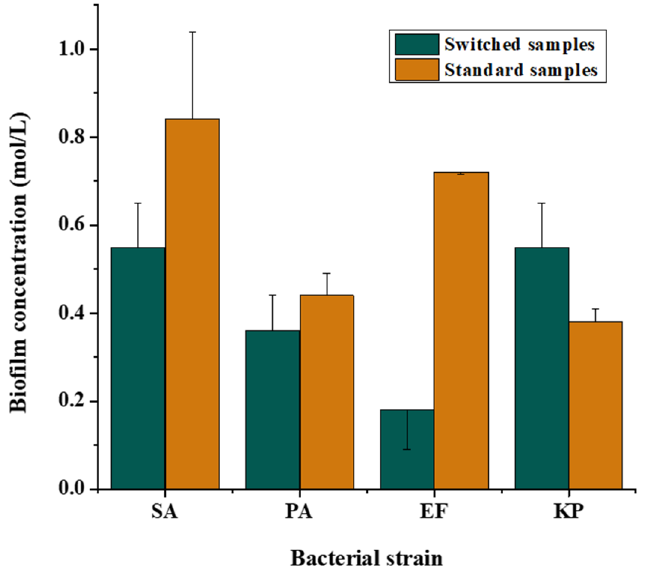
Figure 14. Concentration of the biofilms within the PE side of the channel for each bacterial strain, in standards and switched samples.